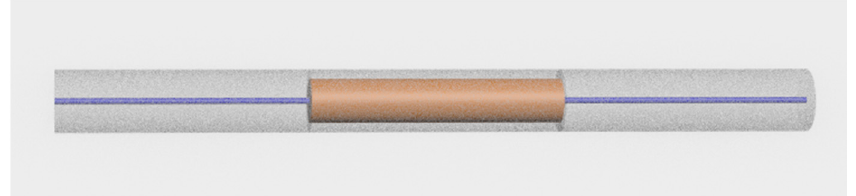
Figure 1. Schematic configuration of an SMS fiber structure [22]. Reproduced with permission from Xianfan Wang, Elfed Lewis, Pengfei Wang, Investigation of the Self-Imaging Position of a Singlemode-Multimode-Singlemode Optical Fiber Structure; published by Wiley Online Library, 2017.